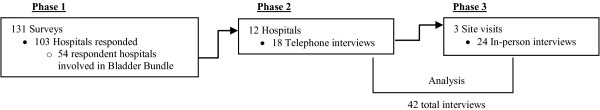
Study design and data collection.